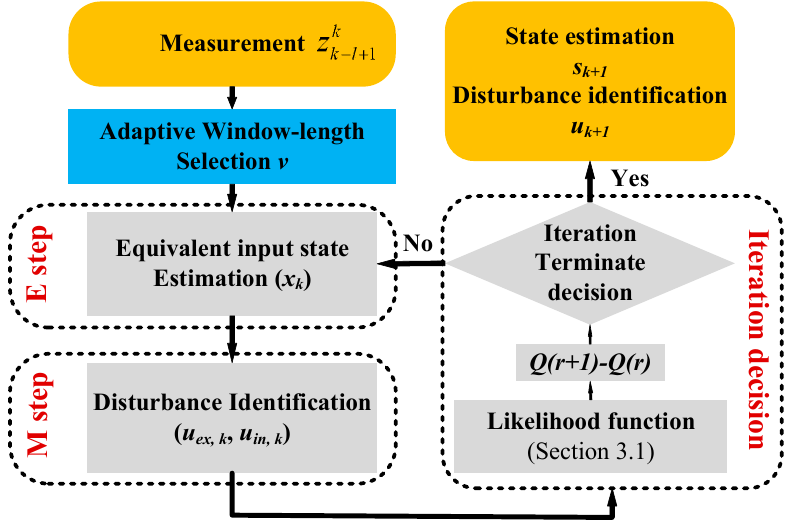
Figure 2. Function flow of the proposed adaptive expectation-maximization (AEM) method.